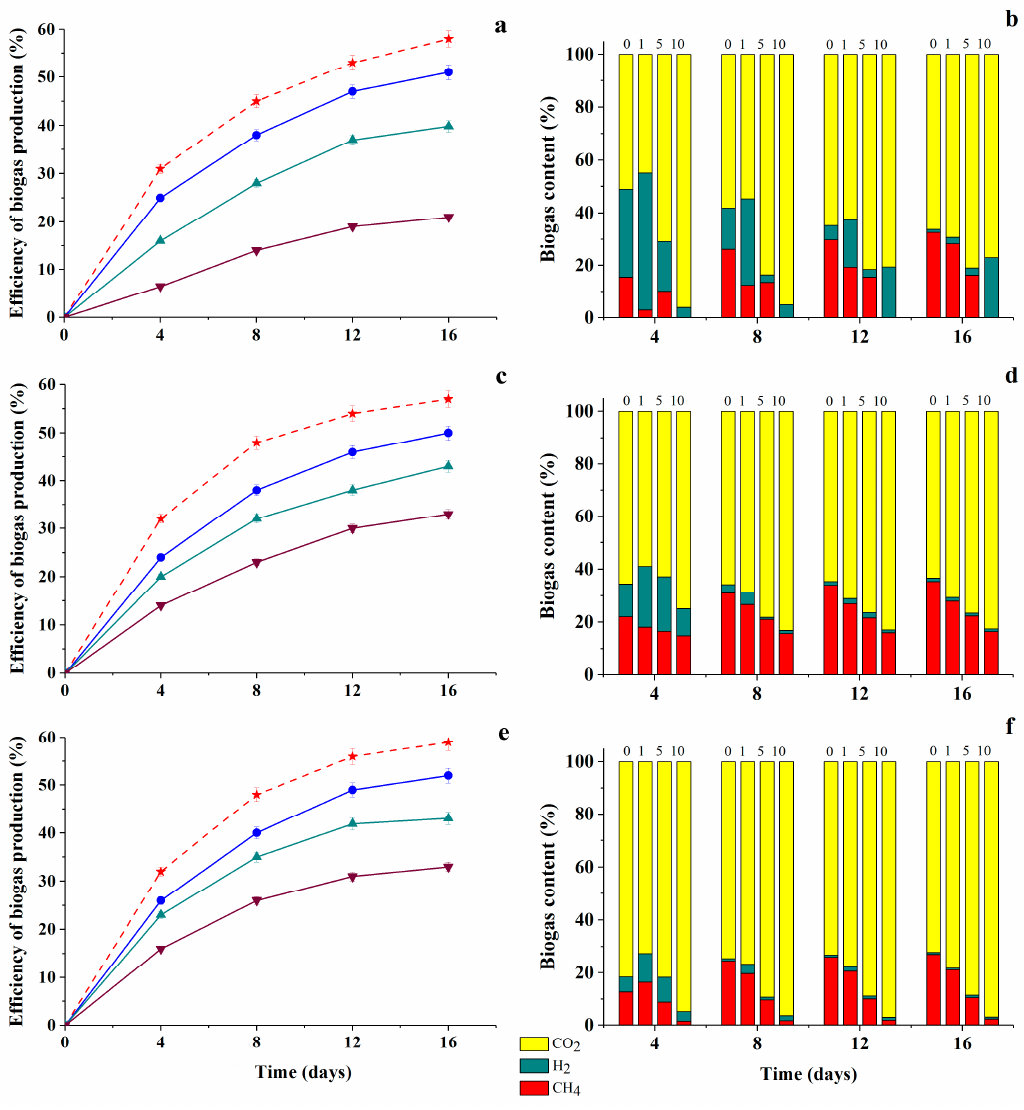
Figure 6. Efficiency of biogas production and biogas content during anaerobic cultivation of natural Figure 7. Efficiency of biogas production and biogas content during anaerobic cultivation of natural anaerobic consortia—the 1st ( a , b ), 2nd ( c , d ), 3rd ( e , f )—in media containing 1 g/L glucose and anaerobic consortia—the 1st ( a , b ), 2nd ( c , d ), 3rd ( e , f )—in media containing 1 g/L glucose and anaerobic consortia—the 1st ( a , b ), 2nd ( c , d ), 3rd ( e , f )—in media containing 1 g/L glucose and anaerobic consortia—the 1st ( a , b ), 2nd ( c , d ), 3rd ( e , f )—in media containing 1 g/L glucose and anaerobic consortia—the 1st ( a , b ), 2nd ( c , d ), 3rd ( e , f )—in media containing 1 g COD/L glucose and different concentrations of FA-HQ (g/L): 1—  , 5—  and 10—  , (  —control sample without HC different concentrations of FA-HQ (g/L): 1—  , 5—  and 10—  , (  —control sample without HC different concentrations of FA-HQ (g/L): 1—  , 5—  and 10—  , (  —control sample without HC di ff erent concentrations of PH-MeHQ (g / L): 1— different concentrations of FA-HQ (g/L): 1—  , 5—  and 10—  , (  —control sample without HC different concentrations of PH-MeHQ (g/L): 1—  , 5—  and 10—  , (  —control sample without in the medium). The theoretical maximal conversion of substrate to biogas was assumed as 100% in the medium). The theoretical maximal conversion of substrate to biogas was assumed as 100% in the medium). The theoretical maximal conversion of substrate to biogas was assumed as 100% in the medium). The theoretical maximal conversion of substrate to biogas was assumed as 100% HC in the medium). efficiency of biogas production. efficiency of biogas production. efficiency of biogas production. efficiency of biogas